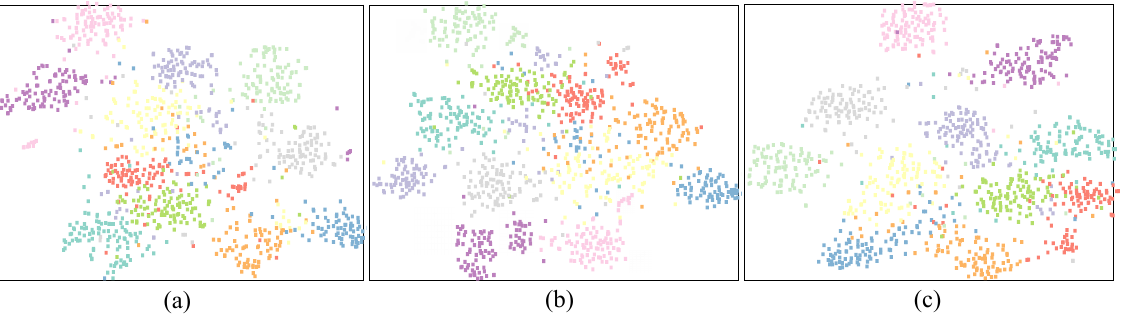
Figure 7. The 2D scatter diagram from the t-SNE algorithm on the NWPU-RESISC45 dataset with an 80% training ratio. ( a ) The student model, trained individually. ( b ) The student model, trained based on traditional distillation loss. ( c ) Our proposed